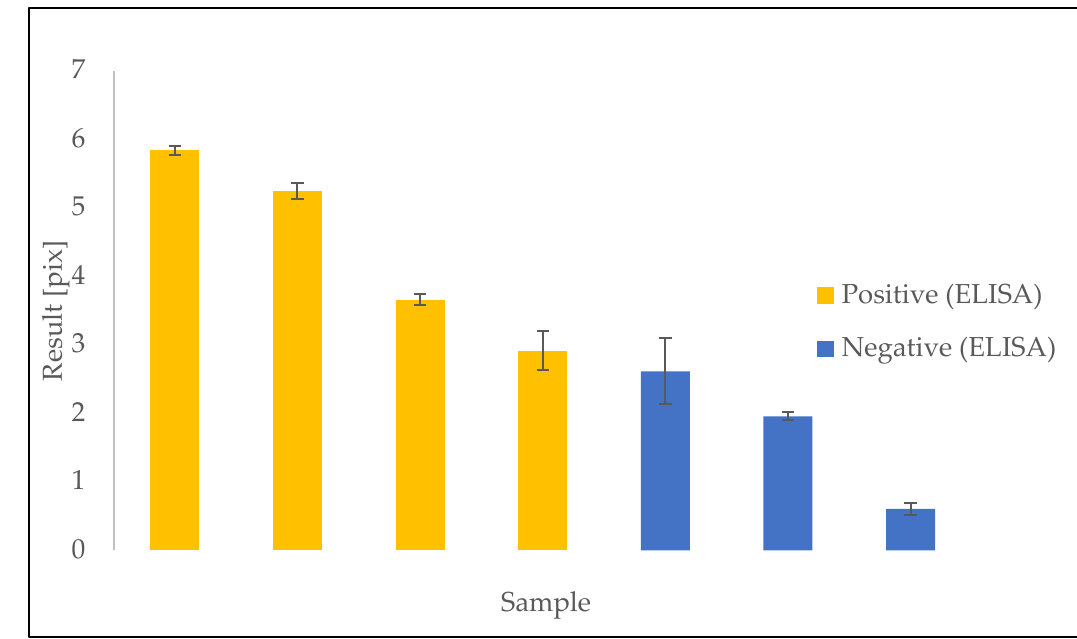
Figure 4. Results of the detection of seven plasma samples. Results compared with the reference according to the ELISA test.